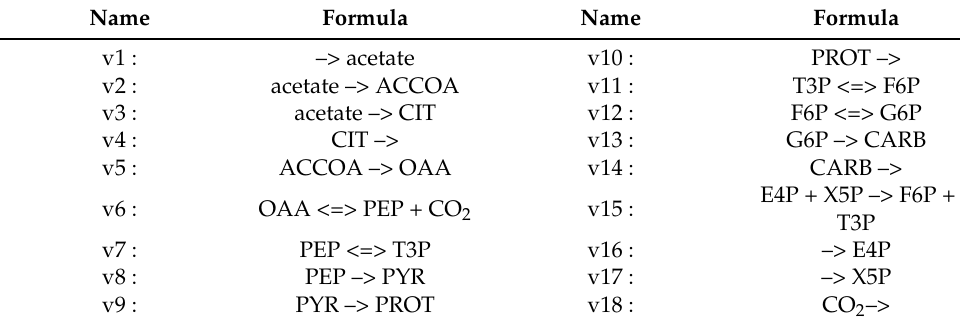
Table 4. Reactions derived from the metabolic network Figure